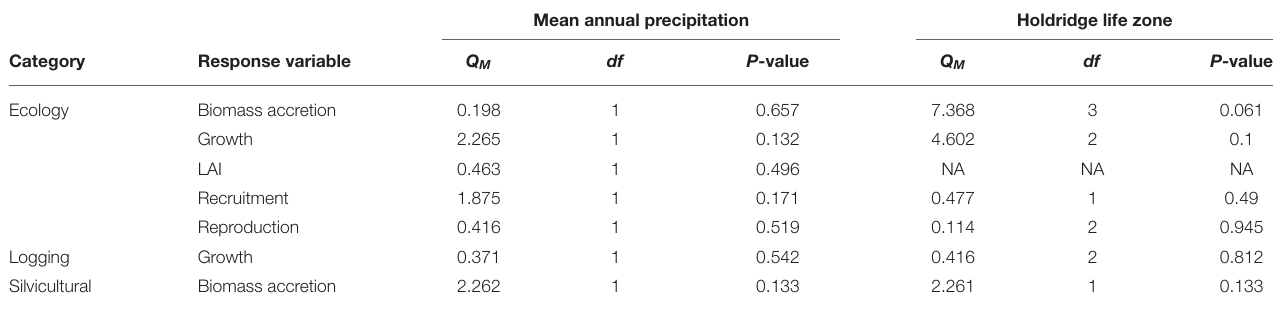
TABLE 2 | Results from omnibus tests to evaluate the effect of mean annual precipitation and Holdridge life zone on response variables that showed a significant effect of liana